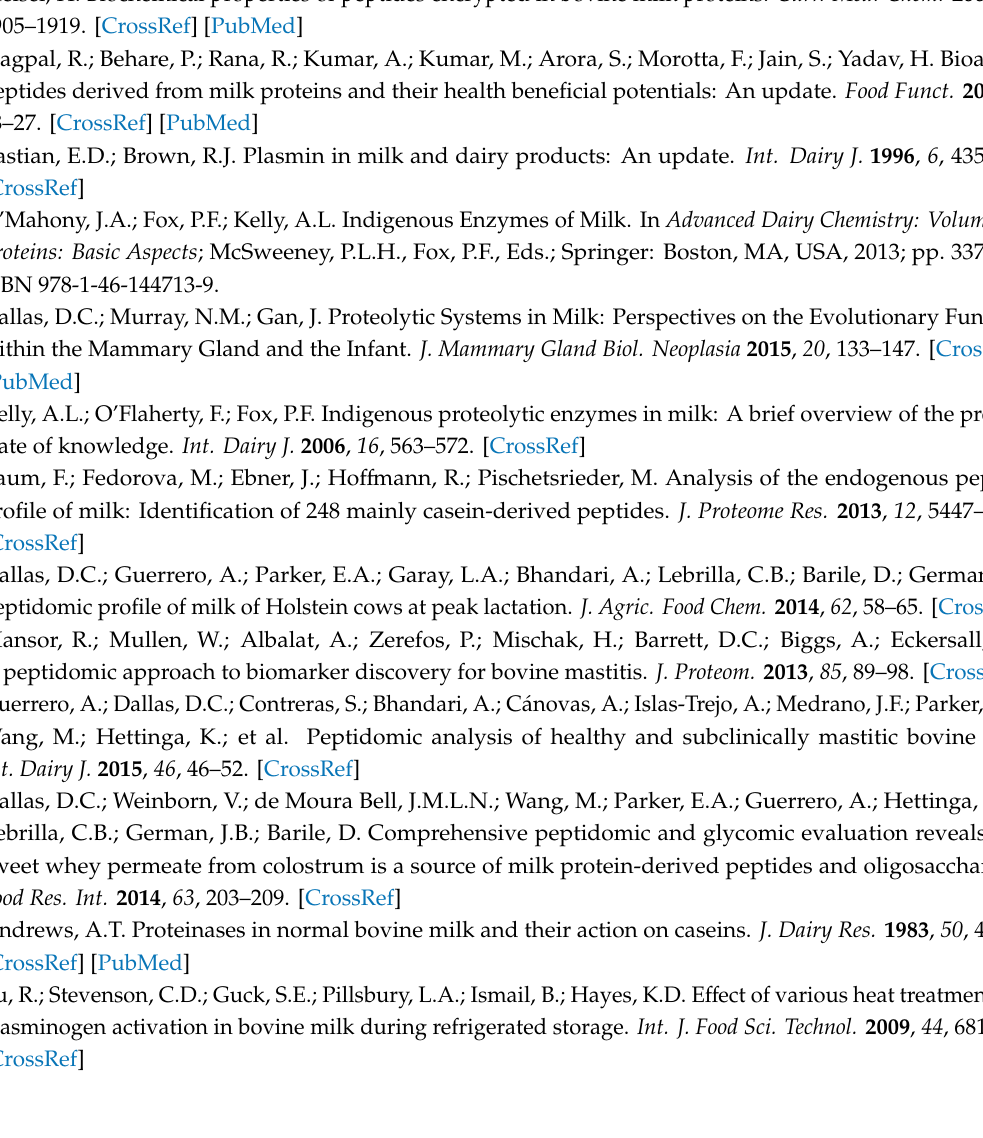
Figure S1: Identification strategy; Figure S2: Overall number of peptides and peptides present in all samples by protein; Figure S3: Protein sequence coverage of α S1 -casein; Figure S4: Protein sequence coverage of α S2 -casein; Figure S5: Protein sequence coverage of GlyCAM-1; Figure S6: Protein sequence coverage of κ -casein; Figure S7: Protein sequence coverage containing modified peptides for α S1 -casein; Figure S8: Protein sequence coverage containing modified peptides for GlyCAM-1; Table S1: List of targeted dynamic modifications; Table S2: List of unmodified peptides sorted by proteins; Table S3: List of modified peptides sorted by